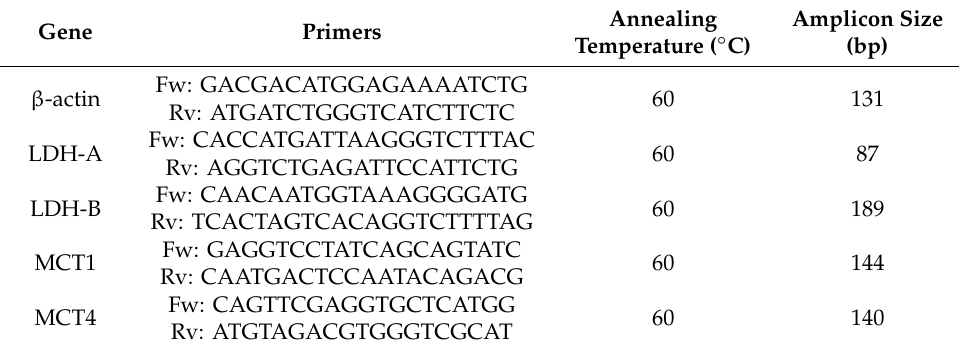
Table 1. Primers used for